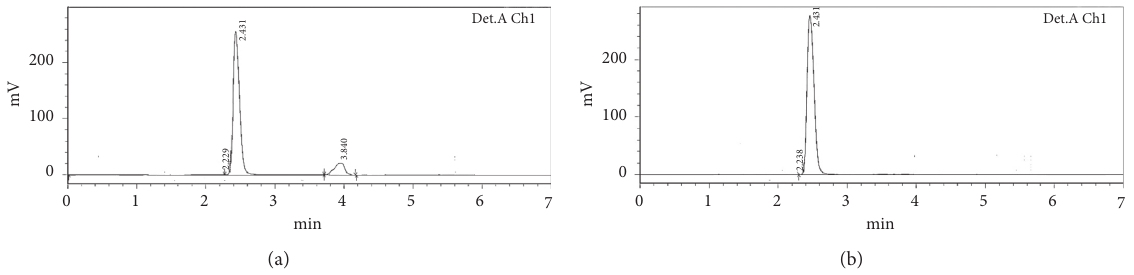
Figure 4: HPLC chromatogram of atorvastatin: (a) acid degradation and (b) base degradation.